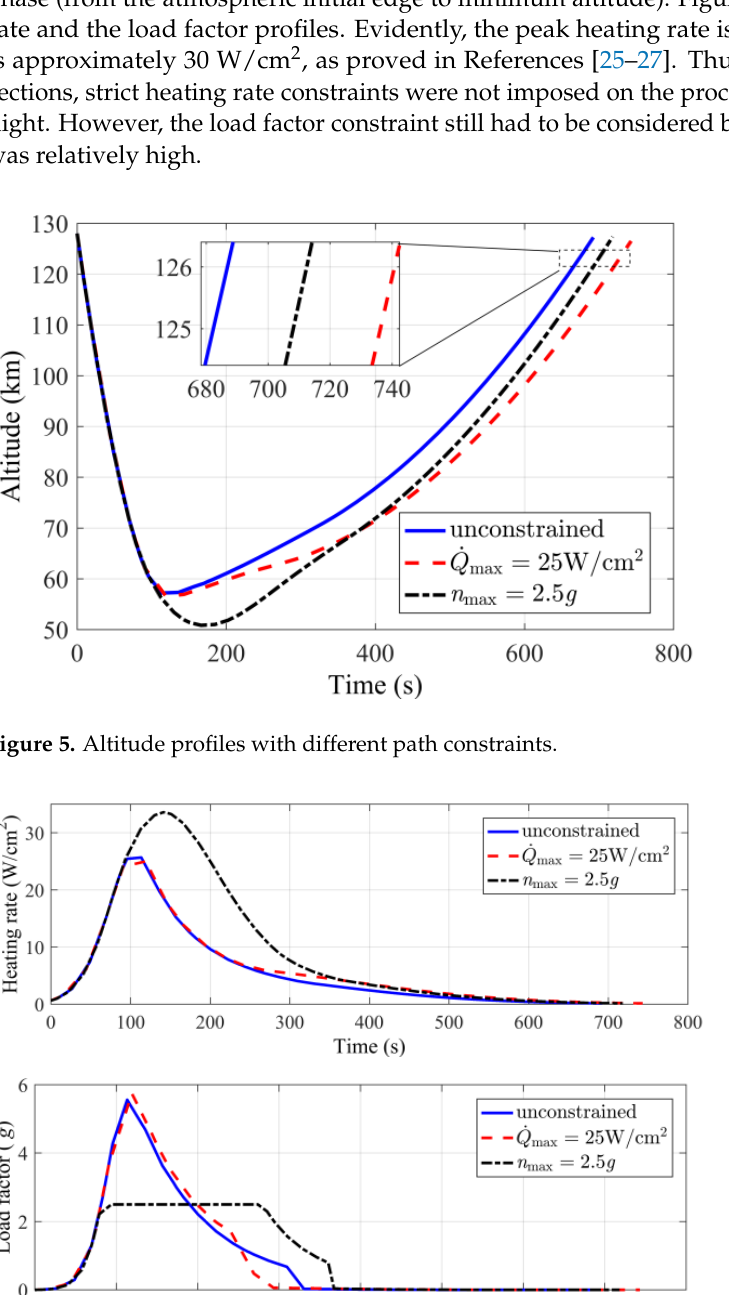
Figure 7. Bank angle and reference area profiles with different path constraints. Figure 8 shows the velocity versus flight path angle profiles under different path con- straints. Since the orbital size and the velocity at the apoapsis of the orbit out of atmos- phere depend entirely on the terminal state variables (at the edge of the atmosphere) f V and